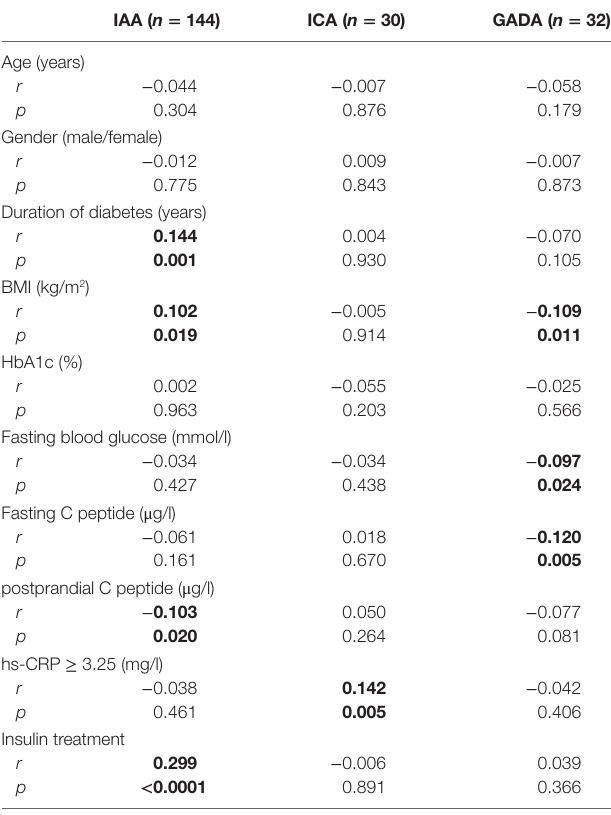
TaBle 3 | Correlation analysis of islet autoantibodies in elderly type 2 diabetes.